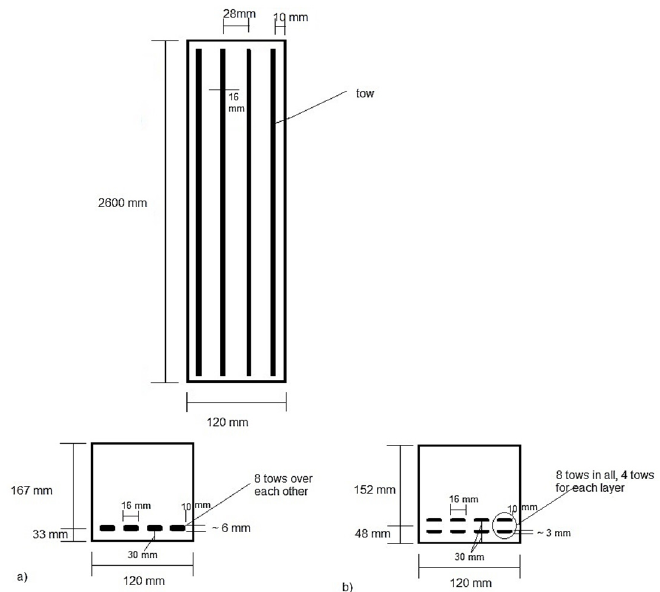
Figure 5. Different layers of textiles in uni-axial TRC beams; a ) 4UT 8 -S-2.6, b ) 4UT 8 -S-L-2.6.